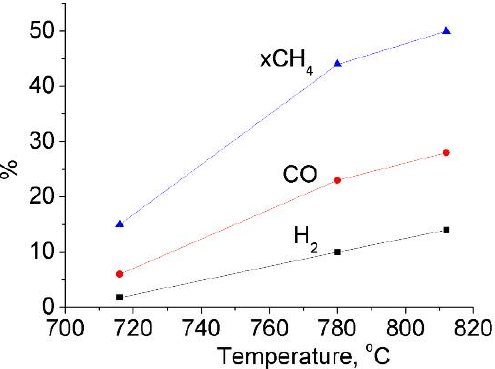
Figure 6. Temperature dependence of CH 4 conversion and CO/H 2 concentrations in NG dry reforming on the package of 5 Fechraloy microchannel plates with 1% NiO+1% Ru /SmPrCeZrO active component. Feed 50% CO 2 +40% NG +N 2 , contact time 0.1